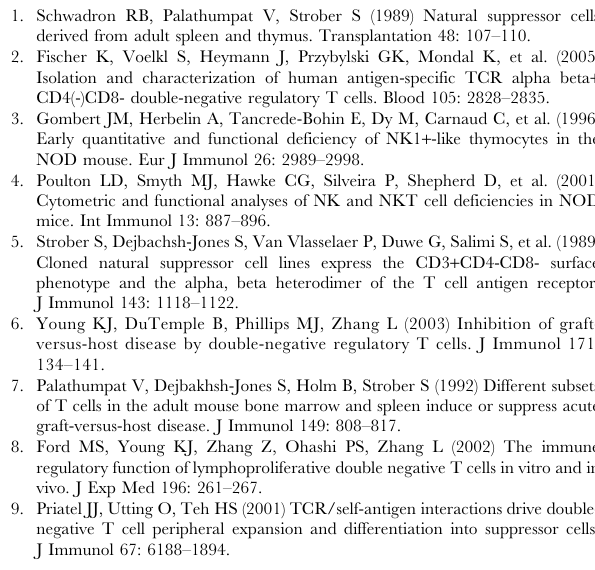
5.0. Shown are the cycles of cell division of CFSE-labeled DNCD3 splenocytes. CFSE serial dilutions of cells labeled in vitro (lower panel) indicate the number of cell cycle divisions. Figure S4 Effect of collagenase method for isolation of lymphocytes on the CD4/CD8 phenotype. Total thymocytes from individual mice were treated in vitro with collagenase preparation as described, then washed in PBS, stained with CD4 and CD8 mAb-dye conjugates, and analyzed by FACS. Shown is a significant loss of CD4 and CD8 surface expression in one of two representative experiments. Figure S5 Lack of Foxp3 mRNA expression in NOD DNCD3 splenic cells. FACS-sorted DNCD3 splenic cells (10 6 cells), and negatively-sorted mature splenic CD4 + T-cells (10 6 control cells) were isolated from 14 day-old female mice (n =10) and stimulated for 5 days under Th1 or Th2 conditions, or for 1 day under T-reg conditions (2.5 m g/ml of CD3/CD28 mAb and TGF- b , as described. mRNA was amplified in RT-PCR using specific primers for Foxp3. Lane 1, molecular markers; lane 2, DN cells stimulated under Th1 conditions; lane 3, DN cells stimulated under Th2 conditions; lane 4, DN cells stimulated with CD3/ CD28 mAbs and TGF- b , and lane 5, splenic CD4 + mature T-cells stimulated with CD3/CD28 mAbs alone. Foxp3 transcript was detected only in splenic CD4 + mature T-cells. Lower panel shows the GAPDH mRNA amplicons corresponding to each sample analyzed in the upper panel. Found at: doi:10.1371/journal.pone.0011427.s005 (1.24 MB